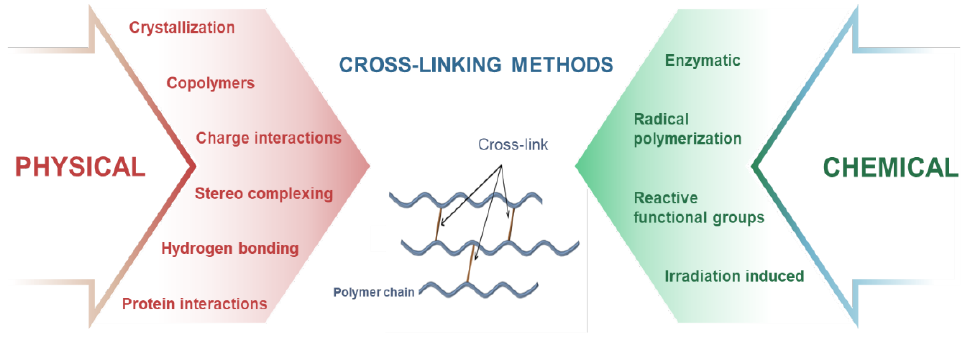
Figure 5. Different methods of crosslinking hydrogels.